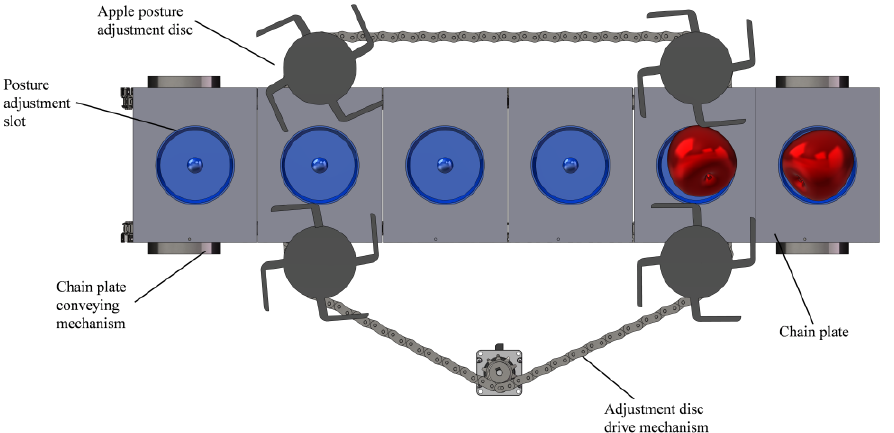
Figure 8. Apple vertical posture adjustment schematic.